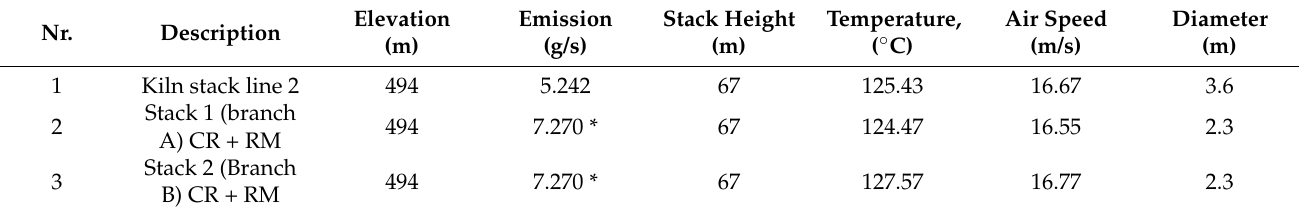
Table 7. Input data in Breeze AERMOD software—SO 2 .